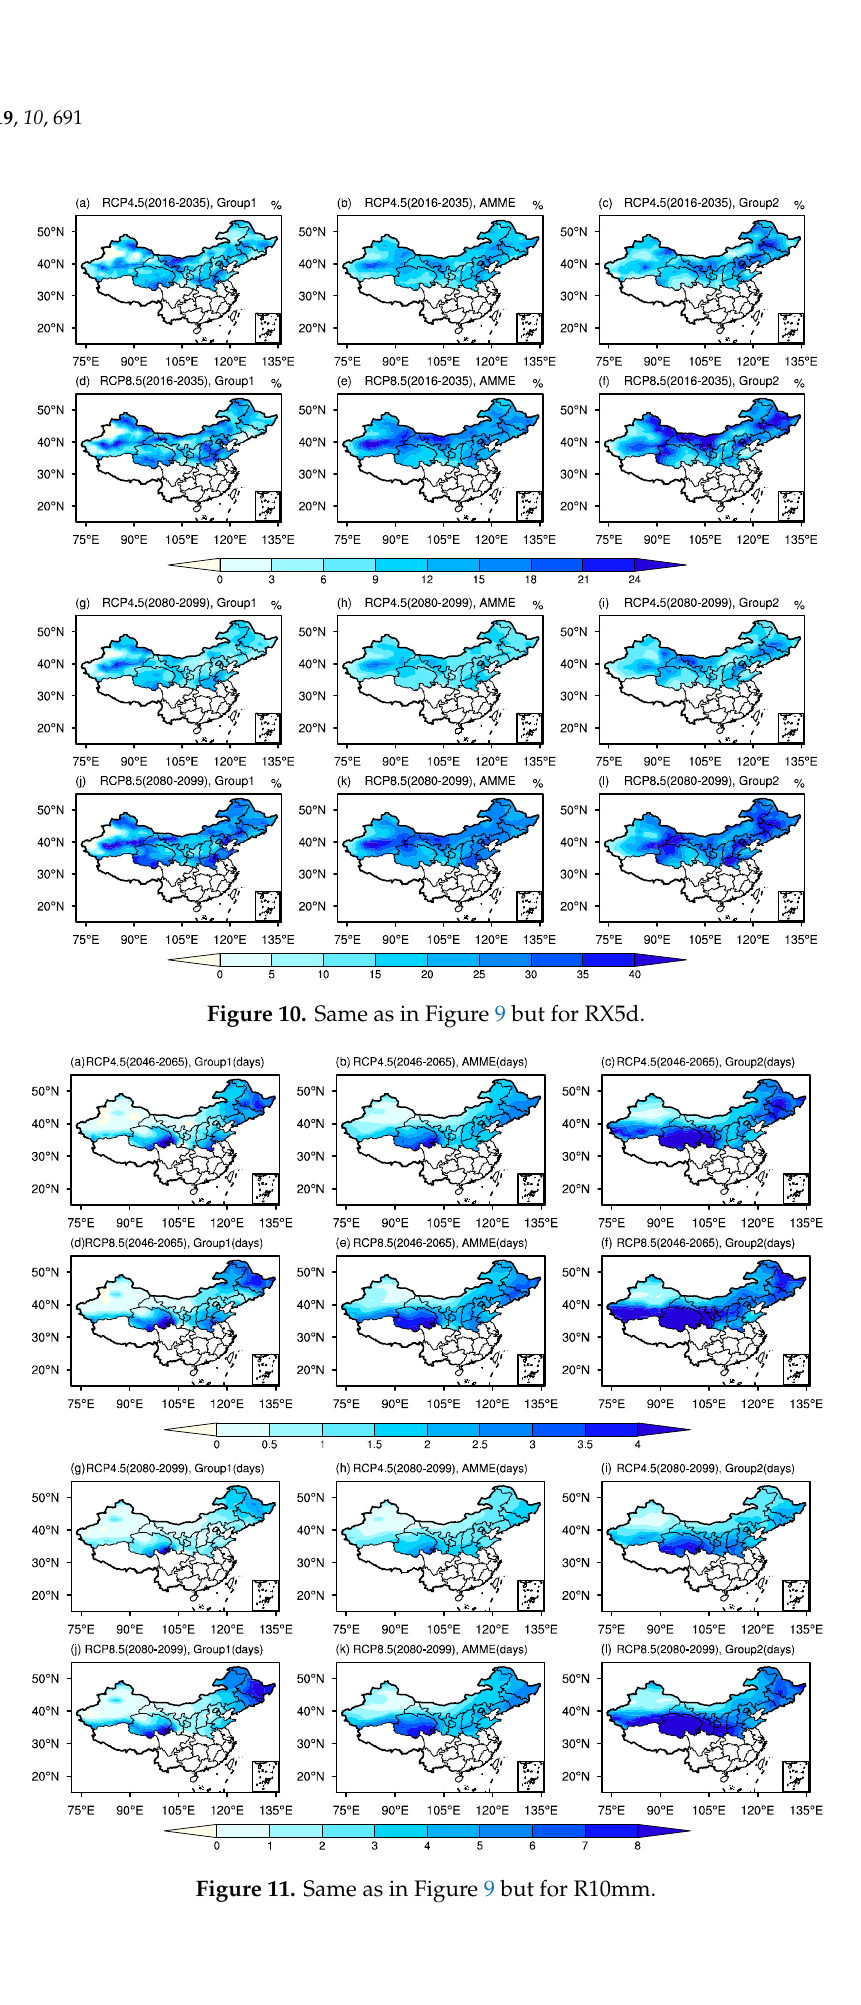
Figure 11. Same as in Figure 9 but for R10mm.